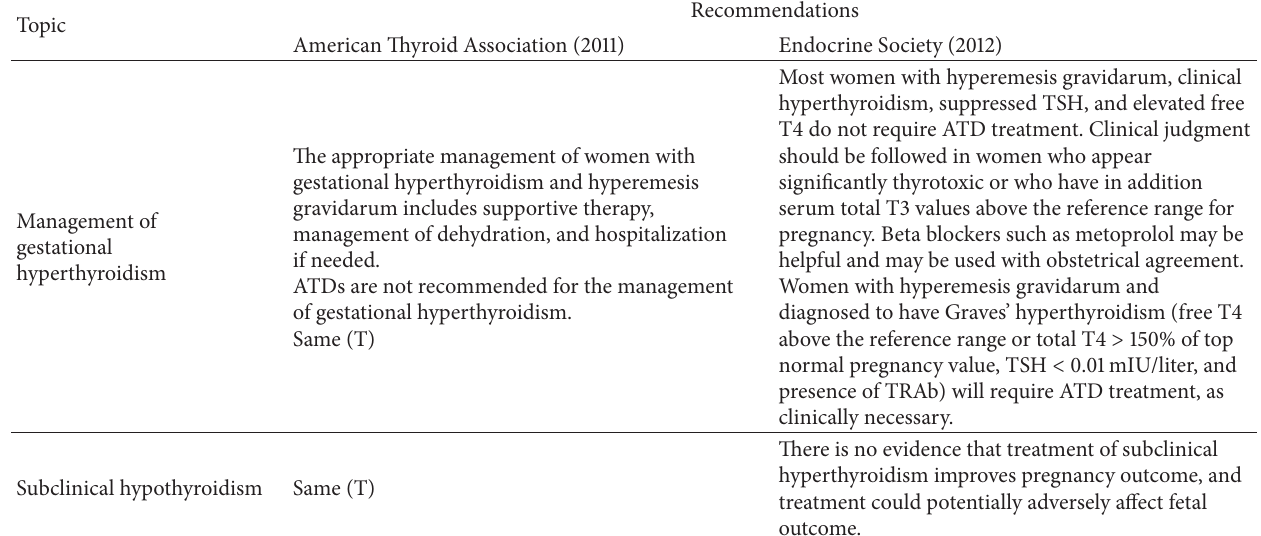
Table 4: Comparison of recommendations of American Thyroid Association and Endocrine Society on other aspects of hyperthyroidism in